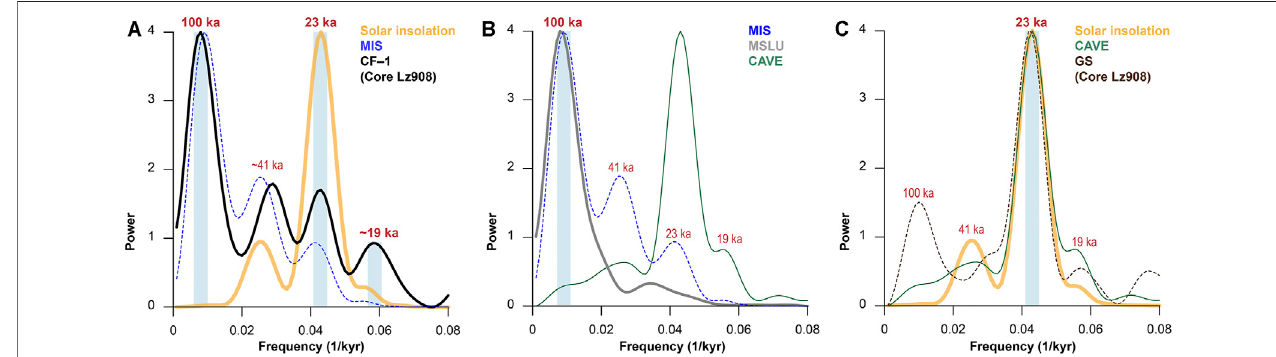
FIGURE 5 | Spectral comparison following the Blackman – Tukey method implemented with the ARAND software package (Howell et al., 2006). MIS, deep – sea sediment δ 18 Orecords(LisieckiandRaymo,2005);MSLU,magneticsusceptibilityrecordoftheLuochuanpro fi le(lowfrequencydata)fromtheChineseloessplateau(Lu and An, 1997); Color (CF – 1) and grain – size (GS) indices of core Lz908; INS (solar insolation), July insolation at 65 ° N (Berger and Loutre, 1991); CAVE, stalagmite δ 18 O series (Cheng et al., 2016).